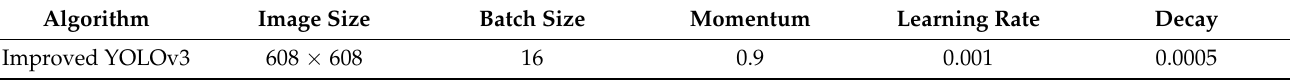
Table 2. Initialization parameters of